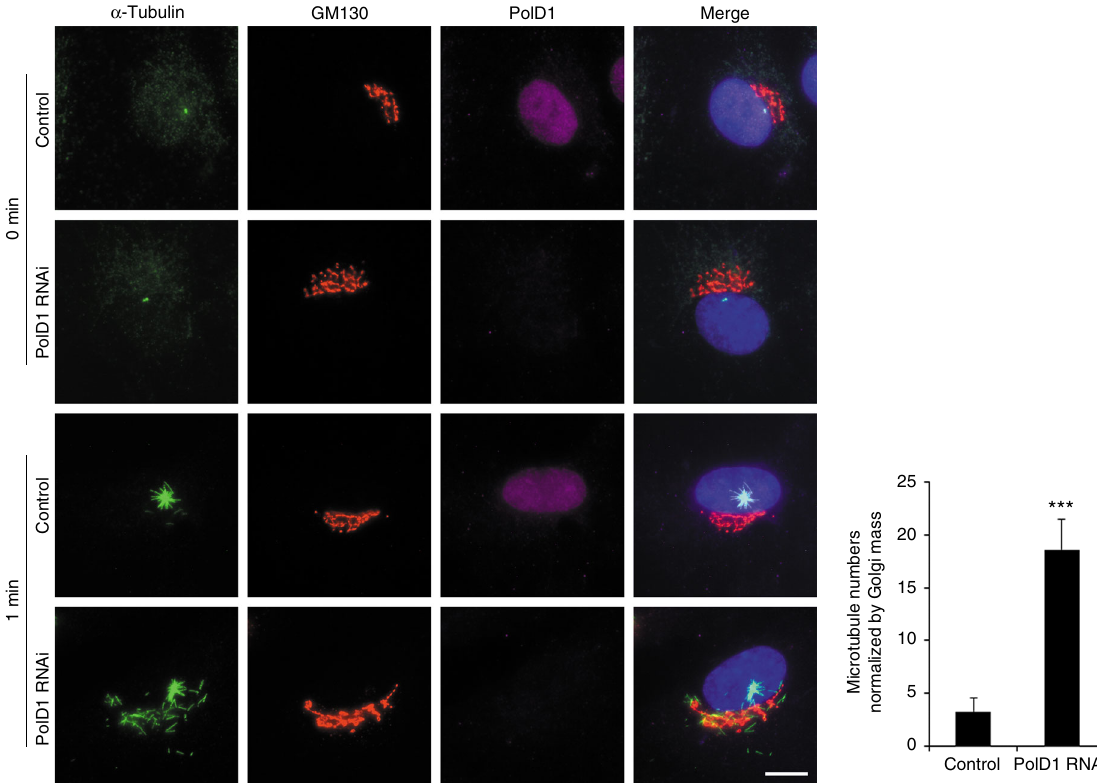
Fig. 4 PolD1 depletion promotes Golgi-associated microtubule nucleation. A microtubule regrowth assay was performed on RPE1 cells transfected with control or PolD1 siRNAs. The cells were then stained for microtubules (anti- α -tubulin) and GM130. The images shown are representative of at least three experiments (100 cells analyzed per condition). Scale bar , 10 μ m. Golgi-associated microtubules at 1 min of regrowth were counted and normalized by the Golgi mass. The data are presented as means ± s.d. and are representative of three independent experiments; *** p < 0.001, two-tailed, unpaired student ’ s t